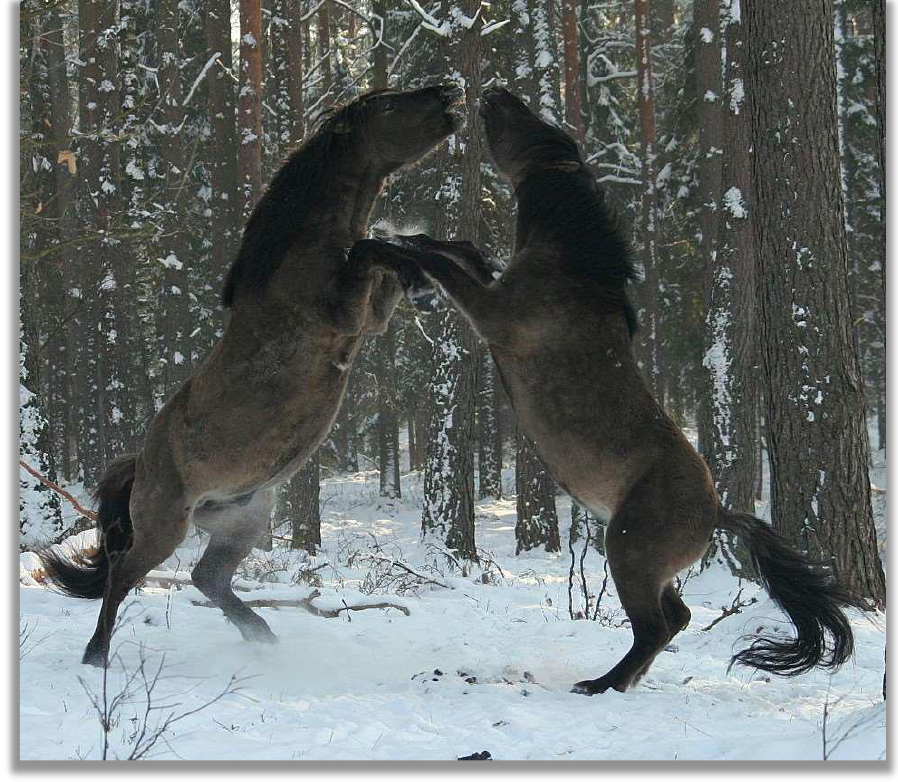
Figure 2. Fighting Konik stallions, Popielno sanctuary, Poland (photo by Michał Bruzda). Another major part of the stallion’s role is group cohesion; stallions will actively search for lost mares and return these to the group. This behaviour is typical of non-territorial species of equids; a plains zebra stallion was once observed taking a sedated mare back to the group by grabbing the fold of her skin with his teeth [28]. Horses recognise individual group members and seem to be aware of the completeness of the familial group [102]. Separated family members (stallions, mares, and foals) have been observed searching for each other when released from transient separation in a field study